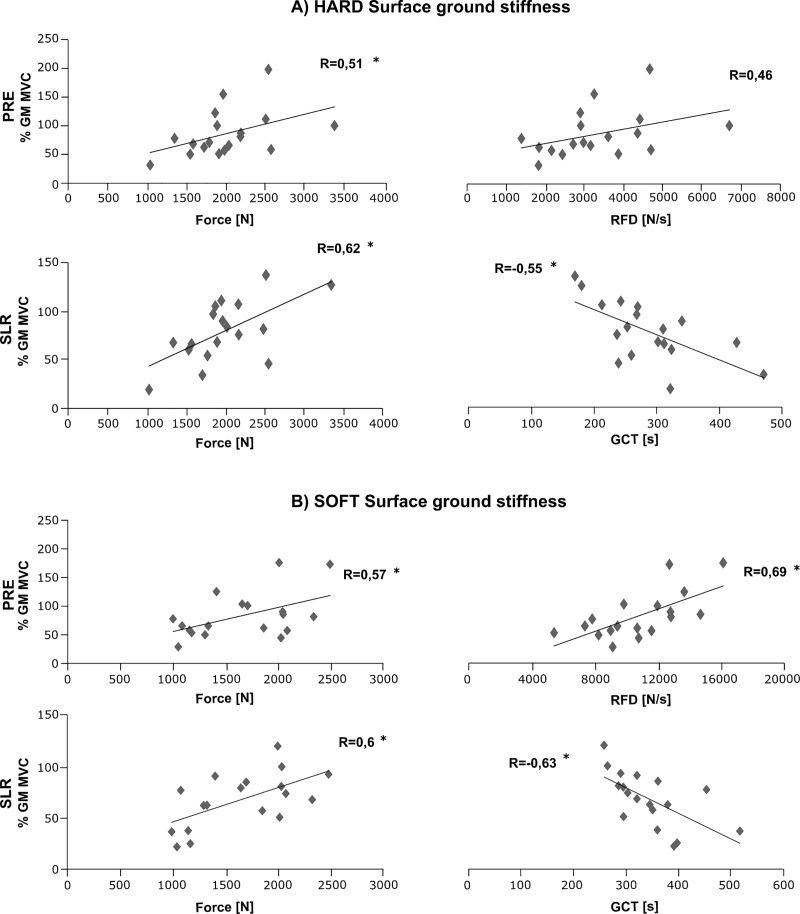
Bivariate correlations and coefficients among the variables peak force, RFD and GCT.Normalised EMGs of the M. gastrocnemius medialis in the relevant EMG phases on the ordinate for the drop jumps performed in the unknown condition in the pre-activation phase (PRE: -150–0 ms before ground contact until ground contact) and the short-latency response (SLR: 30–60 ms after ground contact). For both (A) hard and (B) soft surface ground stiffness, the strength of the relationship between force-time characteristics and the proactive and reactive neuromuscular set was moderate to high. * Significant findings (P < 0.05).